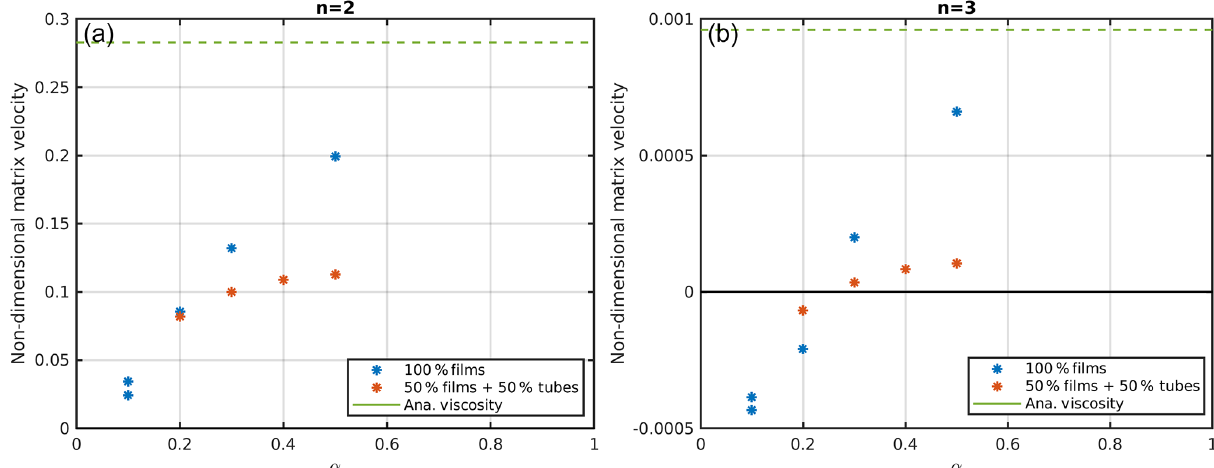
Figure 7. Matrix velocity in the center of a wave with an amplitude of 8 as a function of the aspect ratio of the films for (a) n = 2 and (b) n = 3. The background porosity for all models was